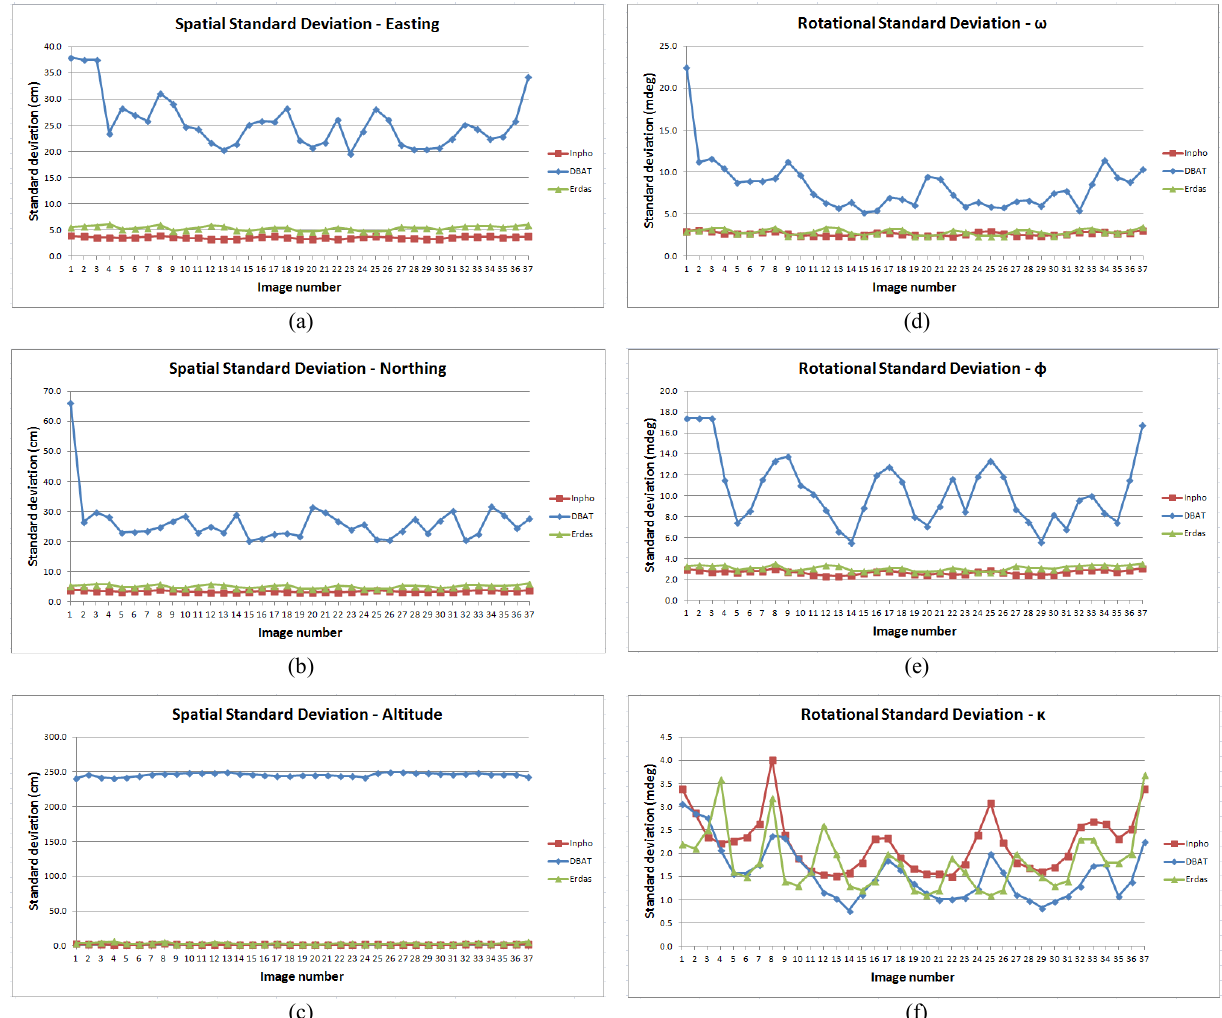
Figure 6. Plotted standard deviation values for the exterior orientation